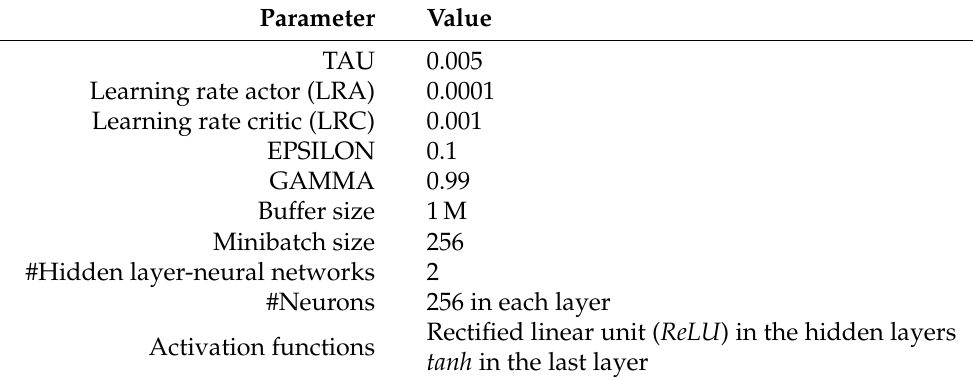
Table 1. Hyperparameters of the employed RL method used in this